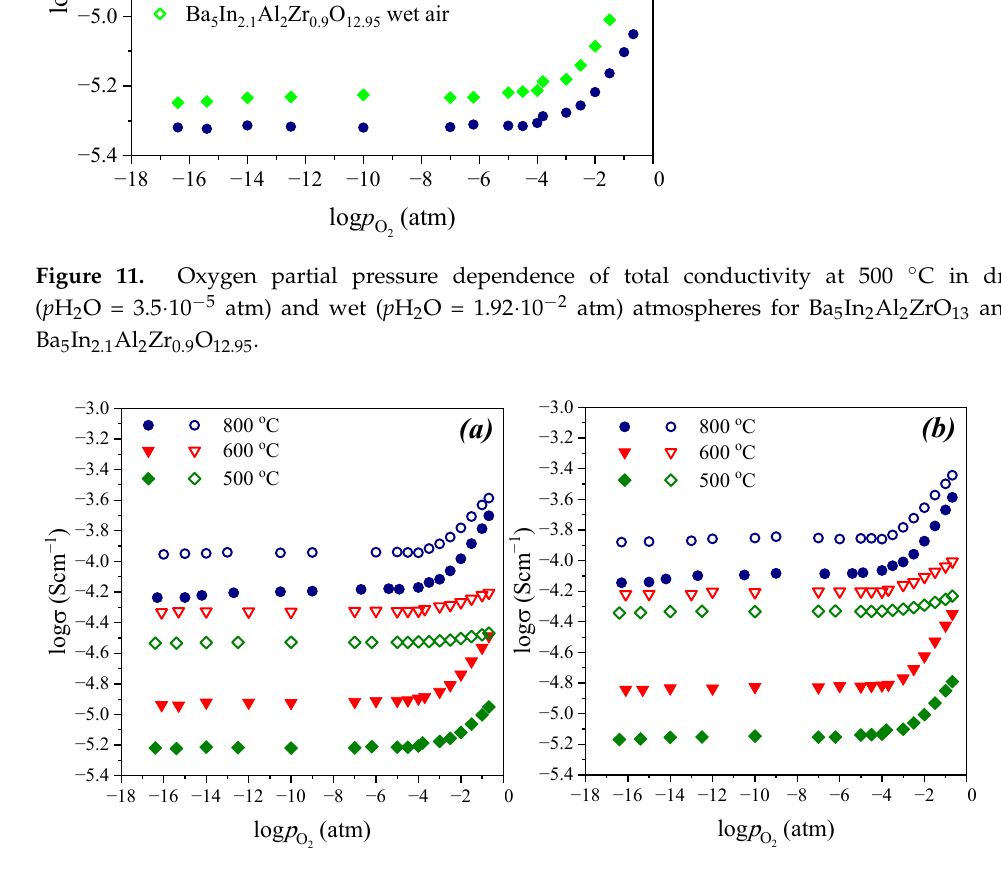
Figure 12. Oxygen partial pressure dependencies of total conductivity in dry ( p H 2 O = 3.5 · 10 − 5 atm) and wet ( p H 2 O = 1.92 · 10 − 2 atm) atmospheres for Ba 5 In 2 Al 2 ZrO 13 ( a ) and Ba 5 In 2.1 Al 2 Zr 0.9 O 12.95 ( b ). According to the data on conductivity dependences vs. oxygen partial pressure, the partial conductivities were calculated in air. For dry air, the values of oxygen-ion conductivities were defined as the conductivity values in the plateau region; the values of hole conductivity were defined by subtracting the ionic conductivity from the total conductivity at p O 2 = 0.21 atm (in accordance with Equation (8)), i.e., σ h = σ (0.21 atm) − σ ion . Proton conductivity values were calculated by subtraction of ionic conductivity in wet atmospheres (the plateau for wet conditions) from the values of oxygen-ion conductivity in dry air (the plateau for dry conditions), i.e., σ H = σ wet ion − σ dry O2 − (assuming that the oxygen ion conductivity is independent of the proton concentration). The values of hole conductivity were defined as a difference of total conductivity value at oxygen pressure 0.21 atm and of the value of ion conductivity. Temperature dependencies of partial conductivities are shown in Figure